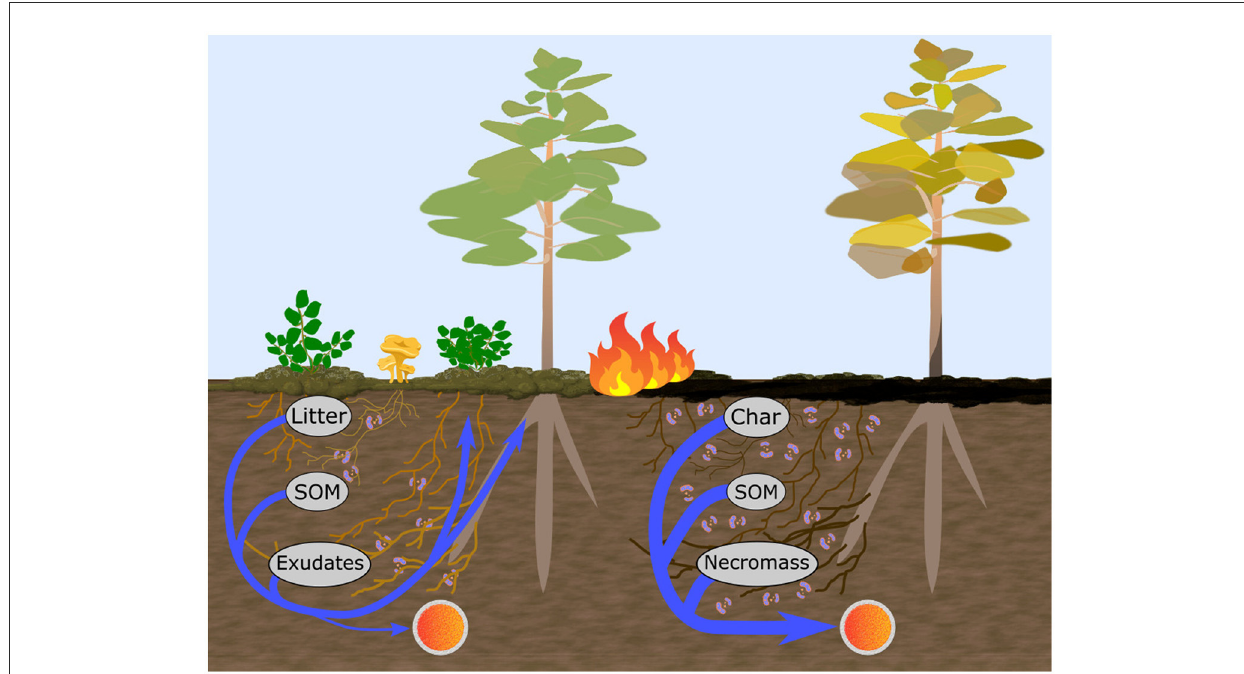
FIGURE1 Conceptual diagram motivating the study hypotheses. Unburnt soils (left) receive inputs of plant-derived litter and root exudates containing labile C. Microbial C copiotrophy and plant nutrient demand promotes retention and/or immediate reuptake of relatively limited N within microbial and plant biomass during processing of organic matter, hindering its net mobilization as measured by ionic-resin capsules (orange spheres) installed at the bottom of the organic soil layer. Burning (right) typically completely removes understory vegetation and increases stand overstory mortality, removing a large portion of fresh C inputs and leaving behind charred material, residual heat-altered soil organic matter (SOM) and necromass (darkened root and mycorrizhal webs to the right). This restriction to a more refractory C pool at 1 year post-fire was expected to induce a wider spread C limitation in the soil thereby increasing dominance of oligotrophic microbial C metabolism (e.g., via increased gram-positive bacteria, right image) which enhances net mobilization of excess N and other nutrients (arrows) found in processed organic